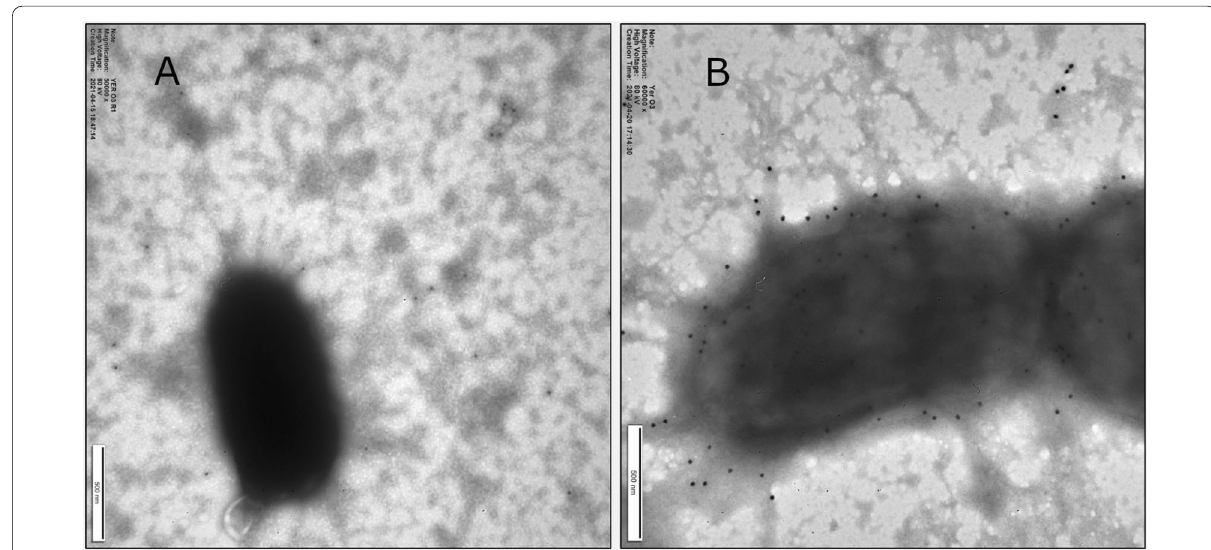
Fig. 5 Specific interaction of H/MTFP‑Gp17 with YeO:3 bacteria visualized by TEM using immunogold labelling. A R1 mutant, the negative reaction with Protein A‑Gold, B YeO:3 wild type strain 6471/76‑c, positive reaction with Protein